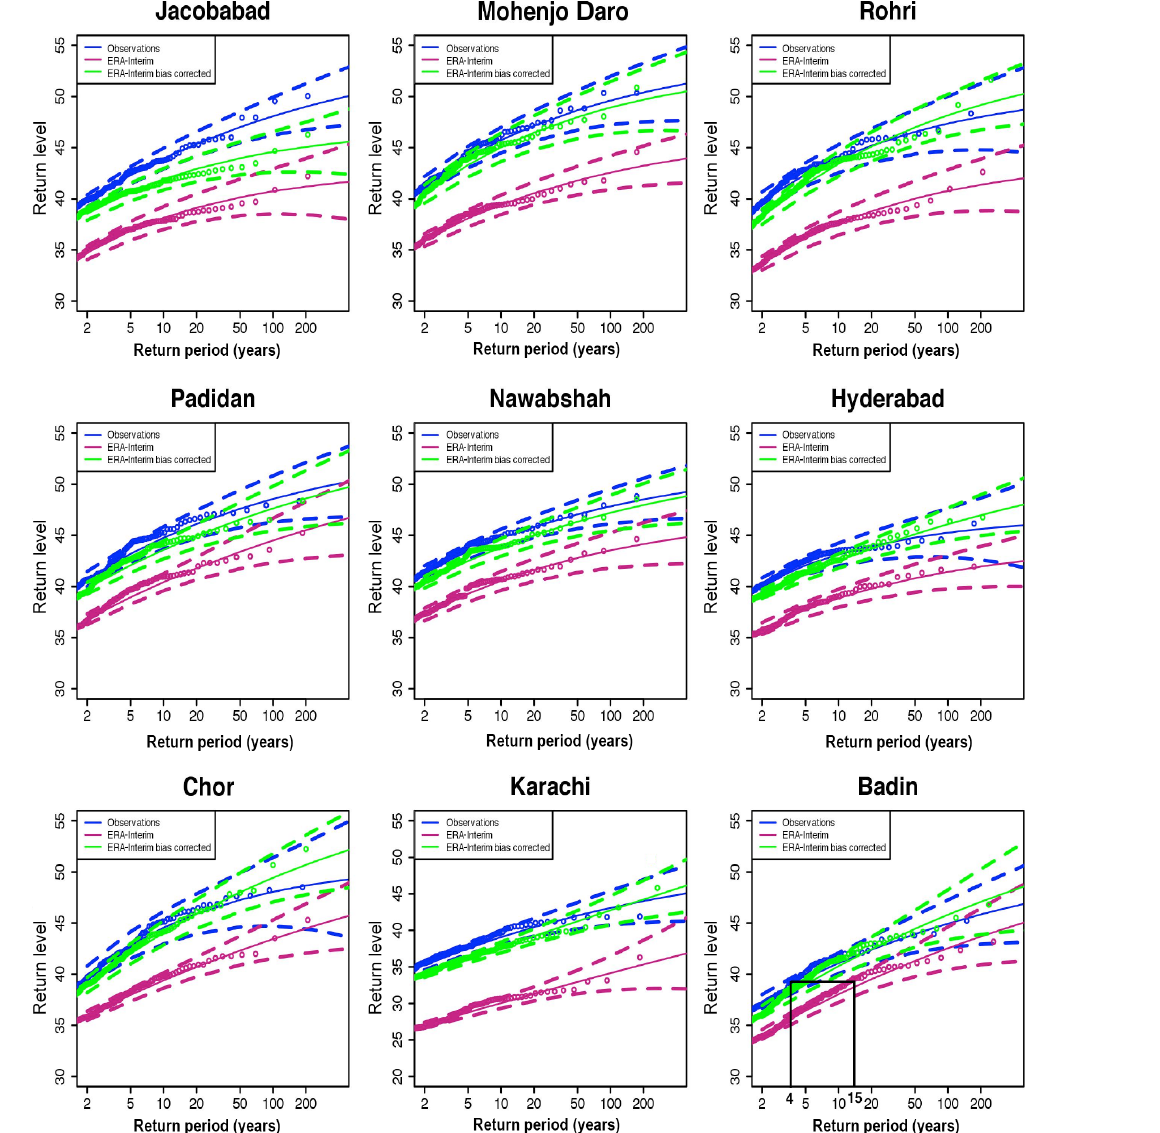
Figure 7. Return level plots of the station-observed TW max (blue), ERA-Interim T max (pink), and bias-corrected ERA-Interim T max (green) in degrees Celsius. The black line is to show a difference in the observed and ERA-Interim